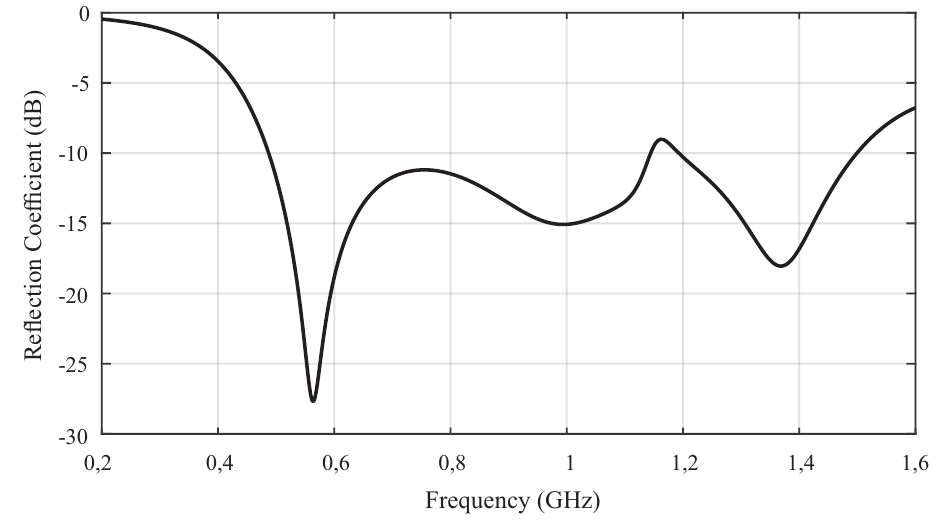
Figure 4. Simulated reflection coefficient for the bio-inspired